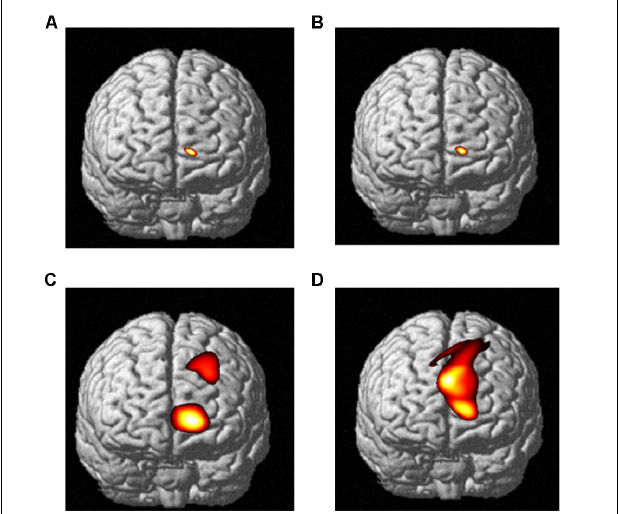
FIGURE 4 | The relative oxyHb concentrations from the DLPFC channels of data obtained from both medical and non-medical subjects under two different conditions. Category: (A) medical subjects under the swab contact condition; (B) medical subjects under the swab contact condition; (C) medical subjects under the acupuncture condition; and (D) non-medical subjects under the acupuncture